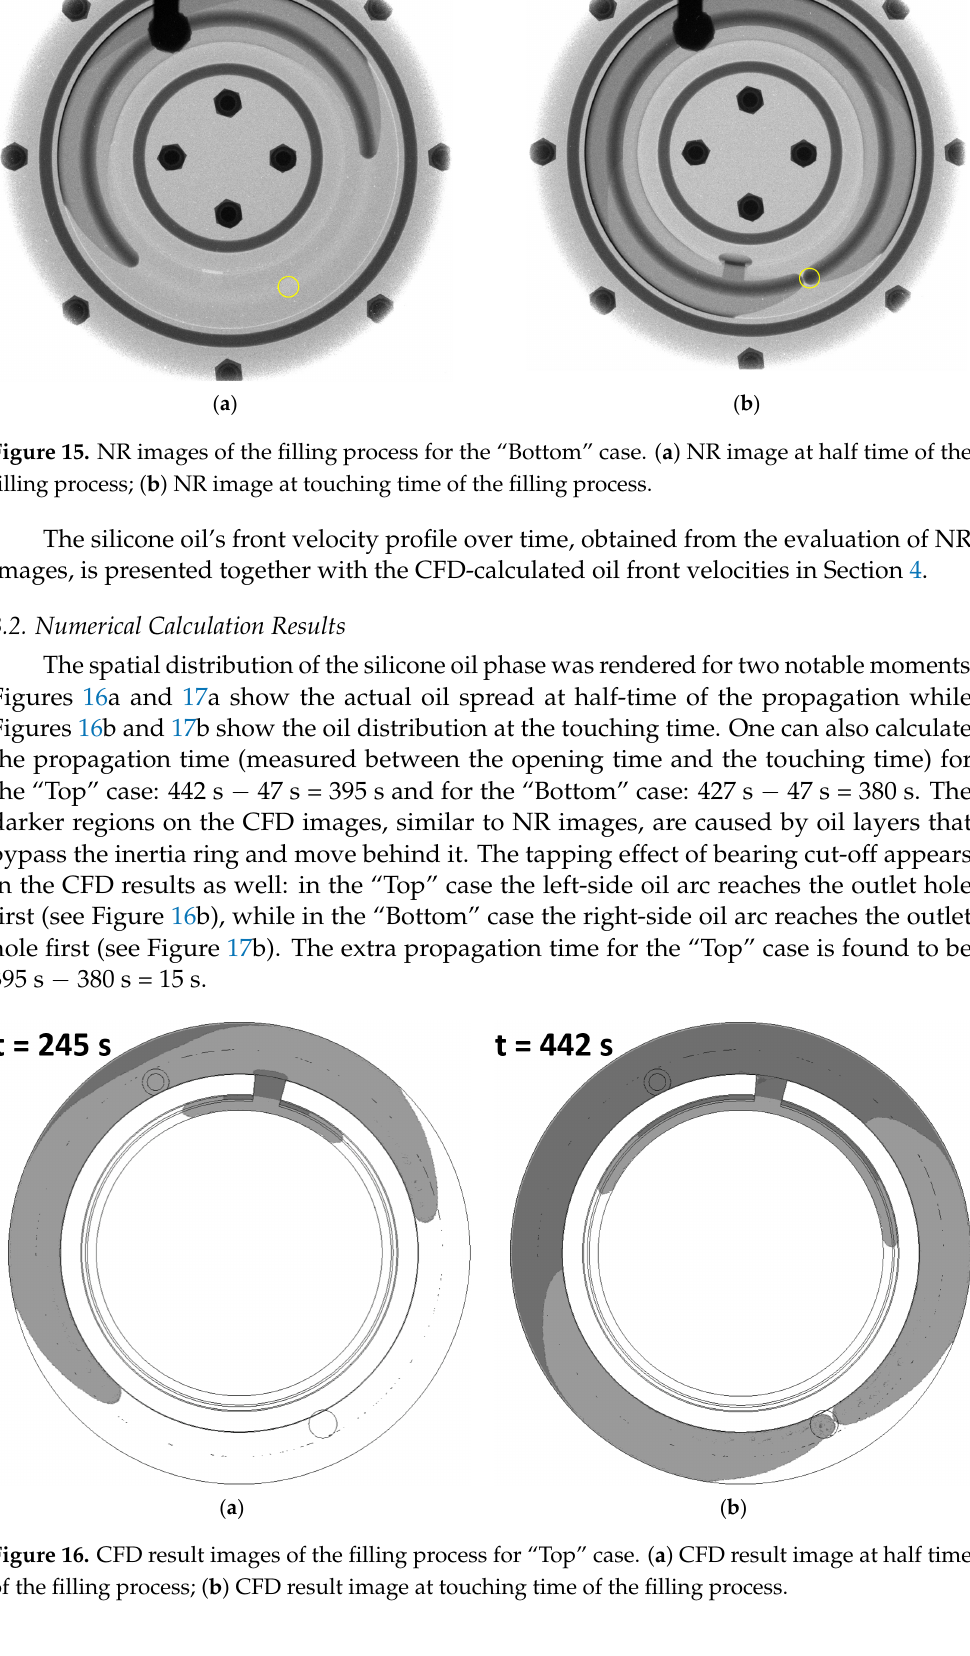
Figure 14. NR images of the fi lling process for the “Top” case. ( a ) NR image at half time of the fi lling process; ( b ) NR image at touching time of the fi lling process.